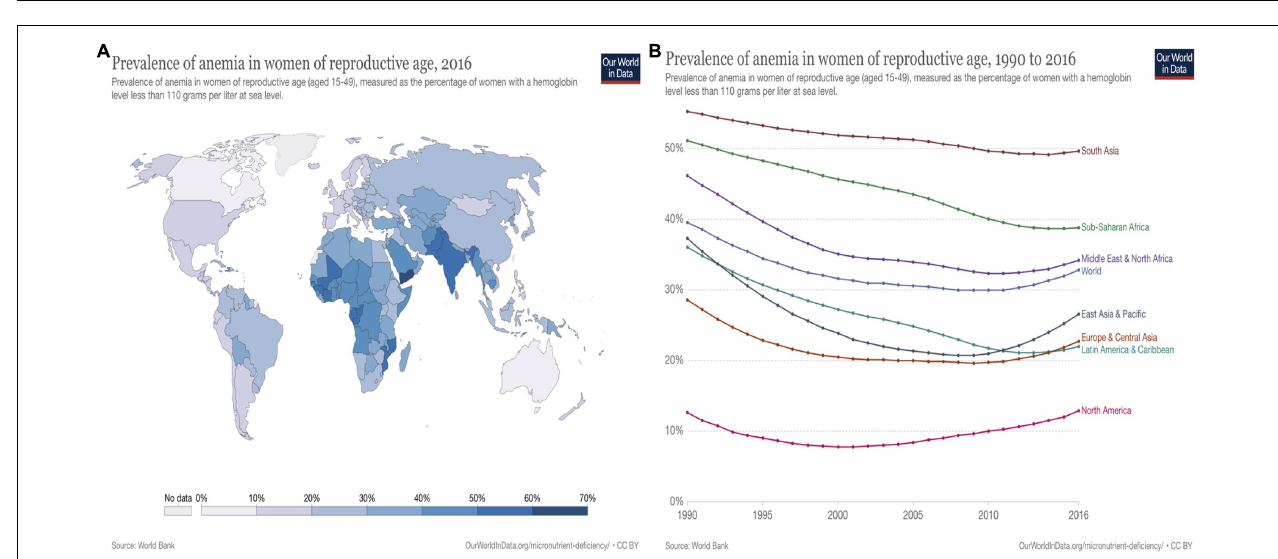
FIGURE 2 | Vitamin B 12 /Iron deficiency: Anemia prevalence in children worldwide (Source: WorldBank; Ritchie and Roser, 2017). (A) Vitamin B 12 /Iron deficiency: anemia prevalence in children worldwide, 2016| Anemia (B12/Fe deficiency) in children under five predominantly occurs in Sub-Saharan Africa regions with average 60% (28.8–86.2%) and Southern Asia 55% (16.9–83.5%) in 2016. The prevalence of anemia occurs less in North America (8.5–9.4%), Europe (12.1–27.1%), Central, East Asia (12.3–21.4%), and Oceania (13–48.4%). Prevalence of anemia relatively correlate to the values of gross domestic product (GDP). (B) Vitamin B 12 /Iron deficiency: anemia prevalence in children worldwide, 1990 to 2016 | Prevalence of anemia (vitamin B 12 /Fe deficiency) has been decreasing worldwide from 1990 to 2016 on average from 51 to 42%. However, it is still a significant issue in Sub-Saharan Africa and South Asia, who have approximately 60 and 55.1% respectively in 2016.